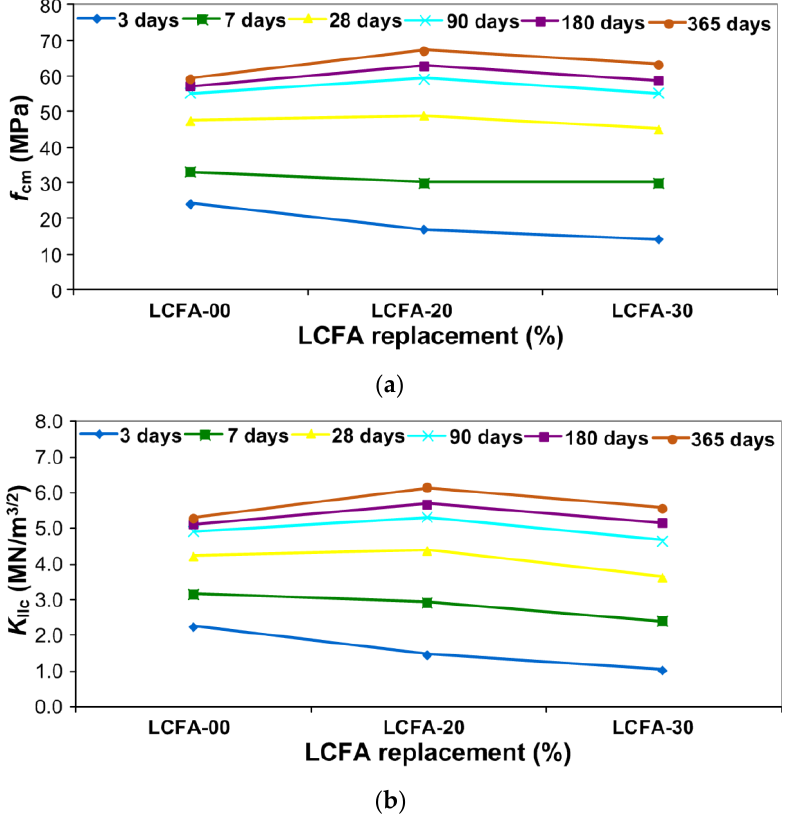
Figure 8. Mechanical parameters of analyzed concretes samples depending on ages: ( a ) compressive strength; ( b ) fracture toughness at shear. Table 6. The results of analyzed mechanical parameters. Concrete